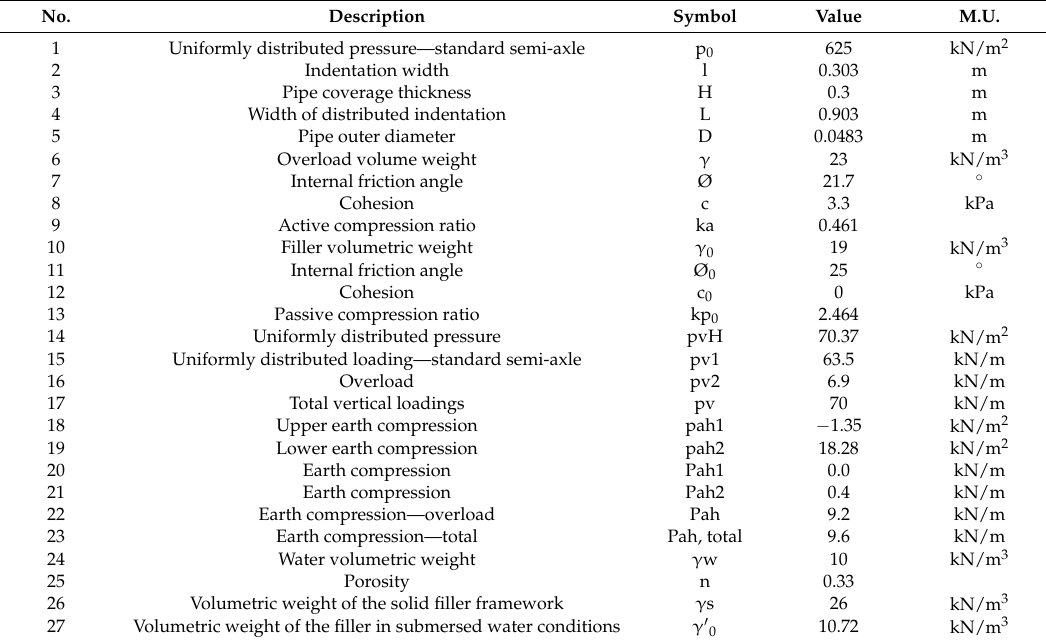
Table 8. Action assessment—characteristic values for Ø 48.3 × 2.6 mm steel